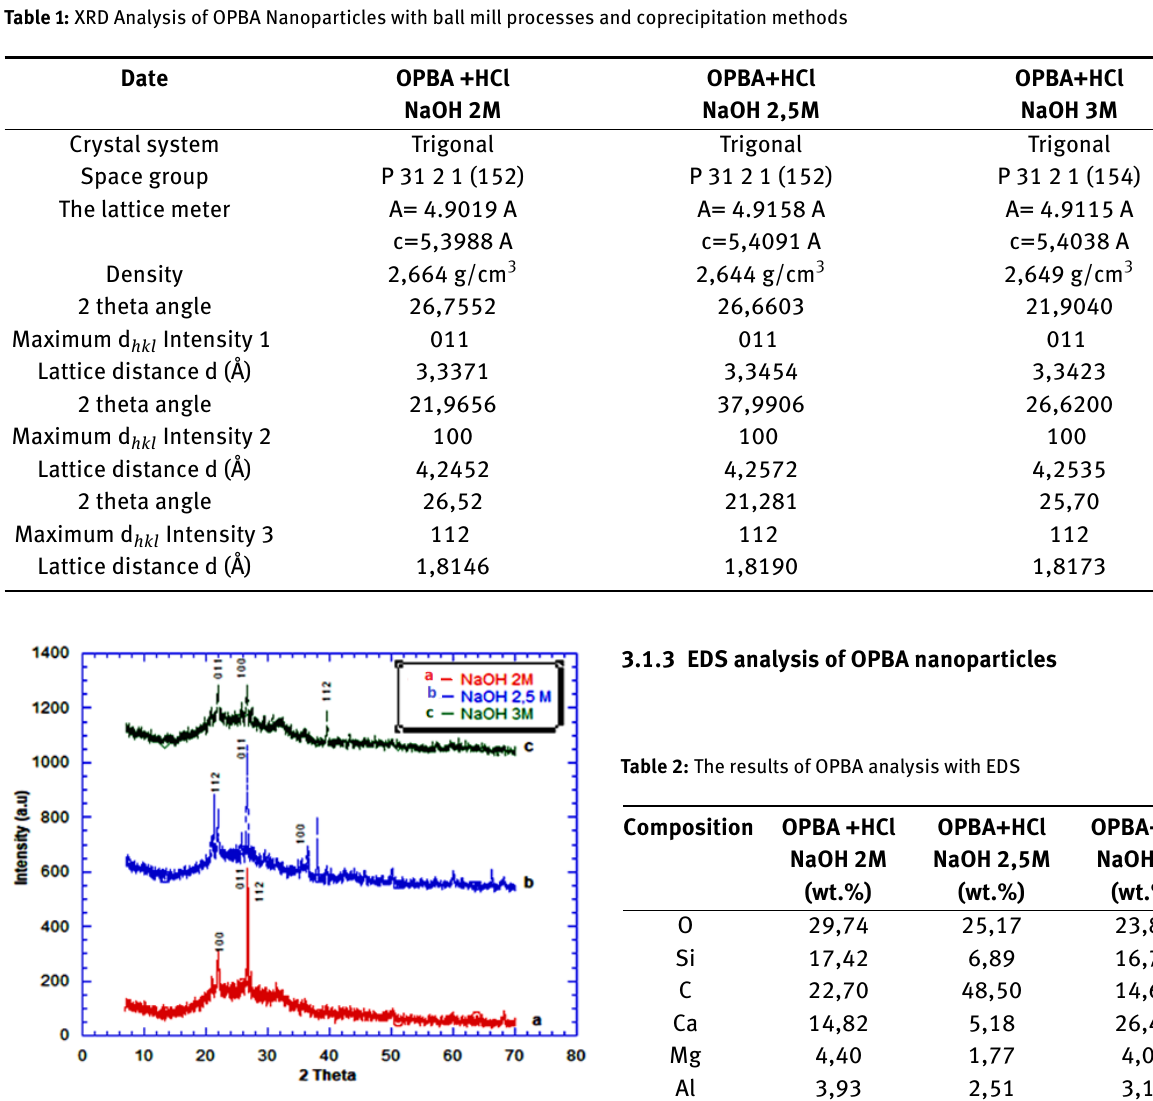
Table 1: XRD Analysis of OPBA Nanoparticles with ball mill processes and coprecipitation methods